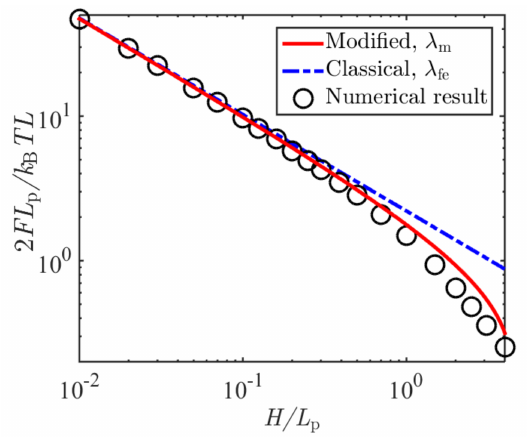
Figure 2. Normalized confinement free energy as a function of the normalized slit height, predicted based on the classical and modified deflection lengths, and the solutions of the eigenvalue